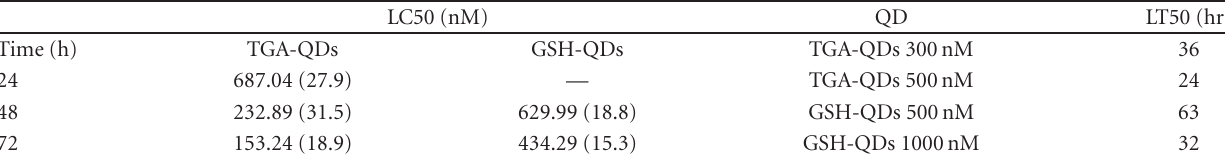
Table 1: Comparison of Mean (SE) lethal concentration (LC50) and lethal time (LT50) for TGA- and GSH-capped